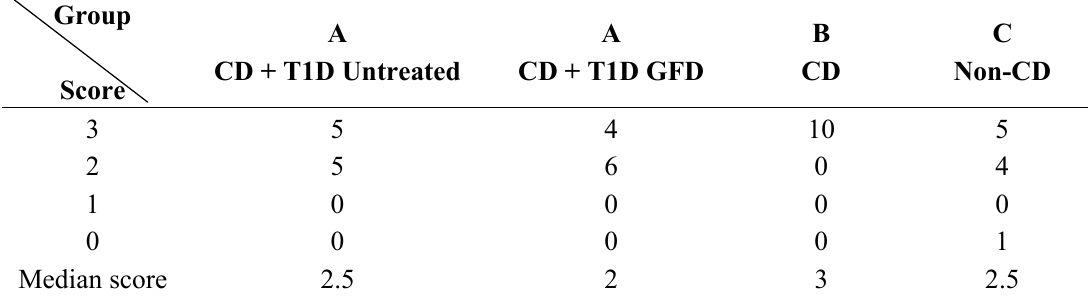
Table 3. Ulex europaeus agglutinin lectin staining scores. Stained sections of biopsies from patients in Groups A (before and after remission), B, and C were scored as follows: 0 represents no staining of the epithelial cell layer, 1 represents staining in the cytoplasm of epithelial cells; 2 represents staining of cytoplasm and glycocalyx; and 3 represents staining of cytoplasm and glycocalyx, as well as goblet